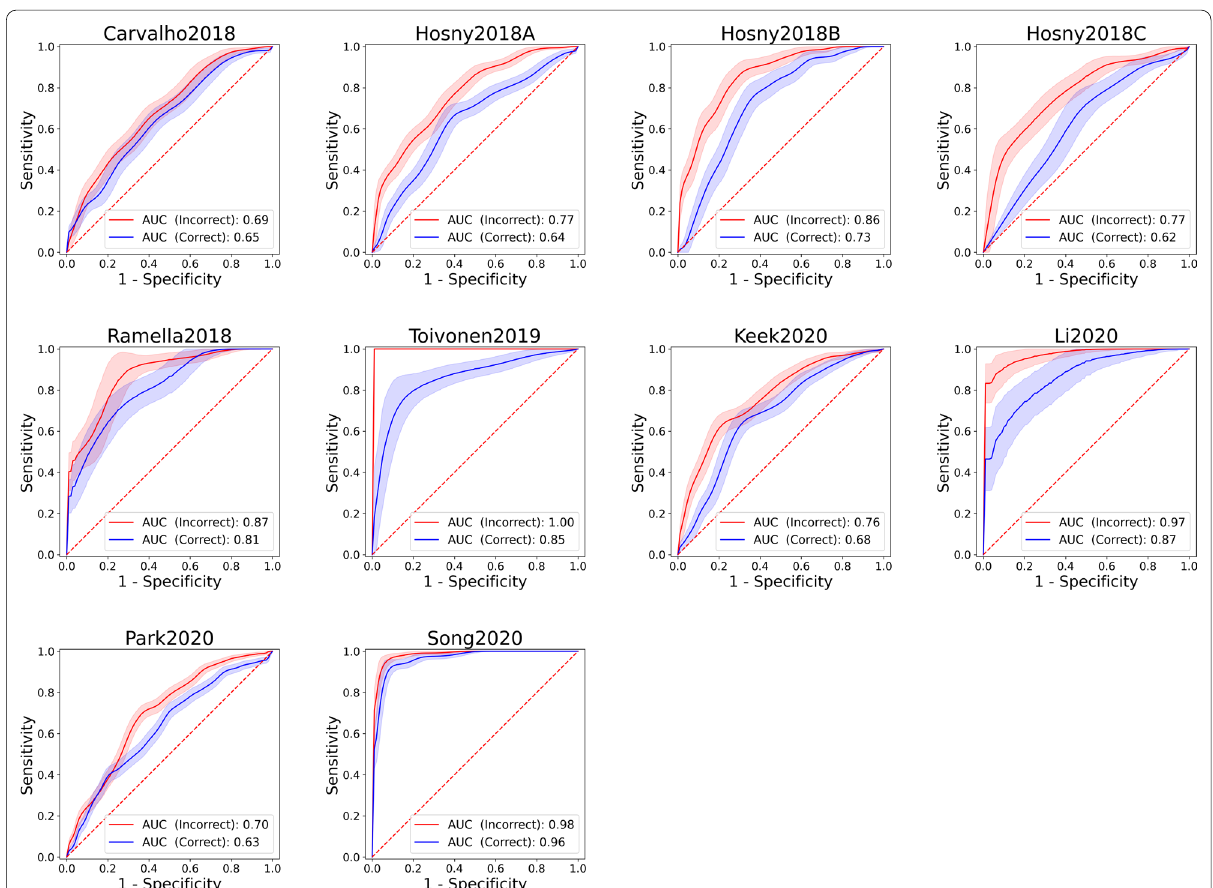
Fig. 2 ROC curves for all datasets. The red and blue curves correspond to application of the feature selection before (Scheme A) and within (Scheme B) the